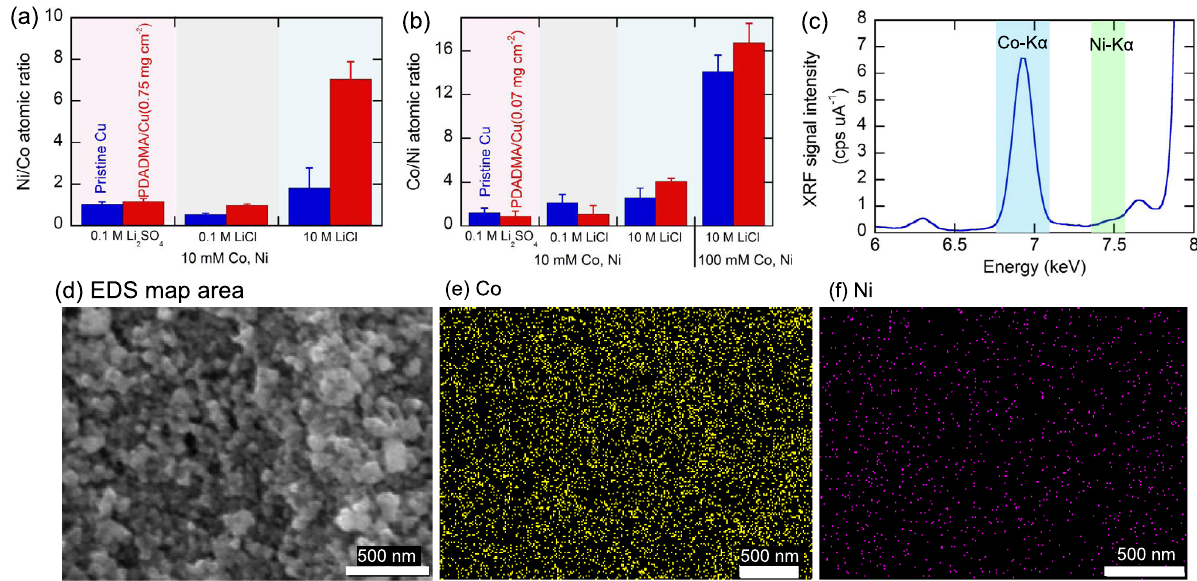
Fig. 4 Synergistic effect of electrolyte and interfacial control. The effect of a background electrolyte and interfacial polymer on a surface Ni/Co ratio at nickel-favored potential of − 0.6 V vs Ag/AgCl and b surface Co/Ni ratio at cobalt-favored potential of − 0.725 V vs Ag/AgCl. c A XRF spectrum and d – f EDS mapping of cobalt and nickel on the electrodeposit formed using PDADMA/Cu (PDADMA loading: 0.07 mg cm − 2 ) at − 0.725 V vs Ag/AgCl in 100 mM Co(II) and Ni(II) in 10 M LiCl. Scale bars for EDS and cobalt/nickel mapping are 500 nm. Error bars indicate standard error of the mean ( n =